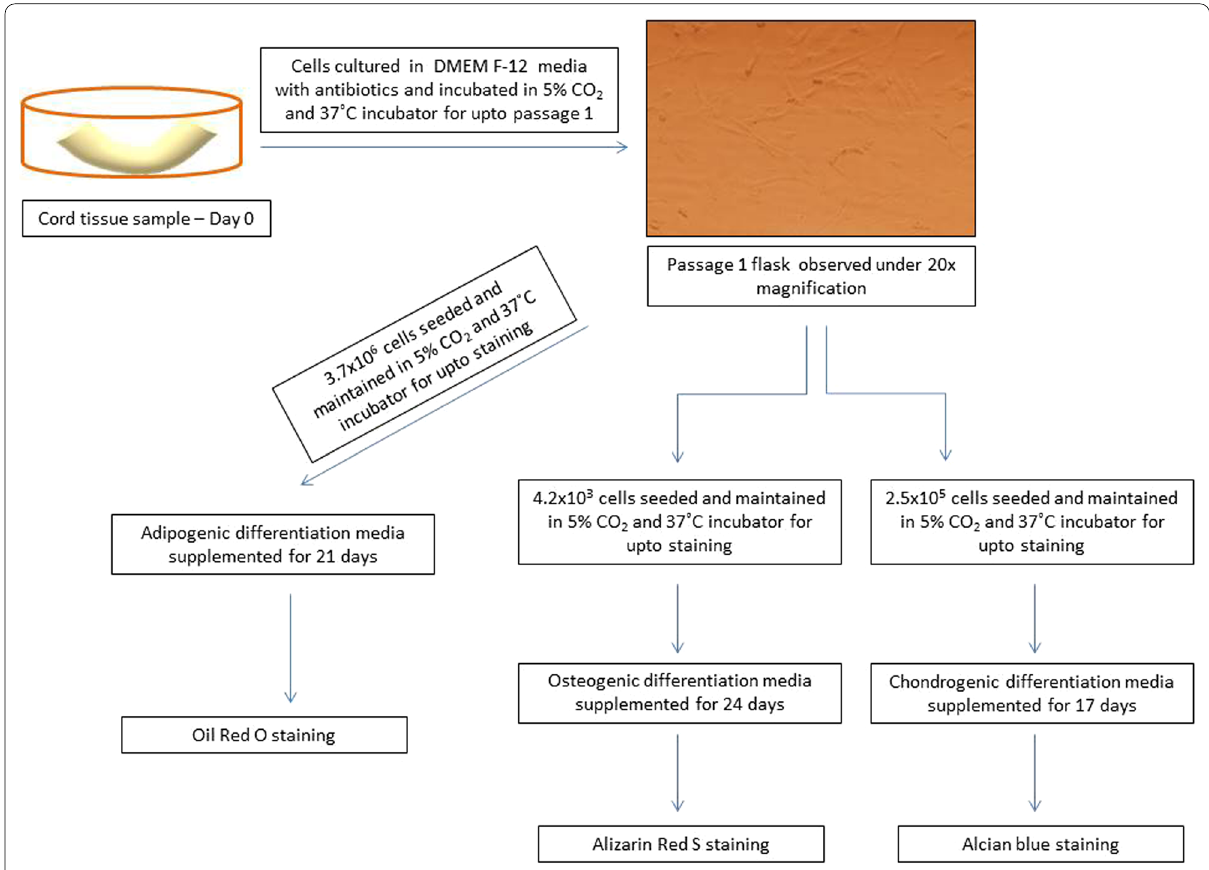
Fig. 1 Schematic representation of UCMSCs differentiation induction and